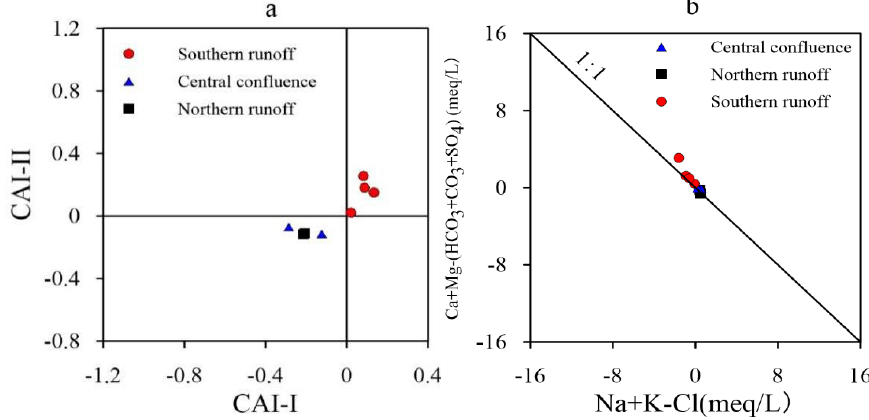
Figure 12. ( a ) CAI-I and CAI-II for ( b ) [(Ca+Mg)-(HCO 3 +SO 4 )] and [(Na+K)-Cl] in lake water.